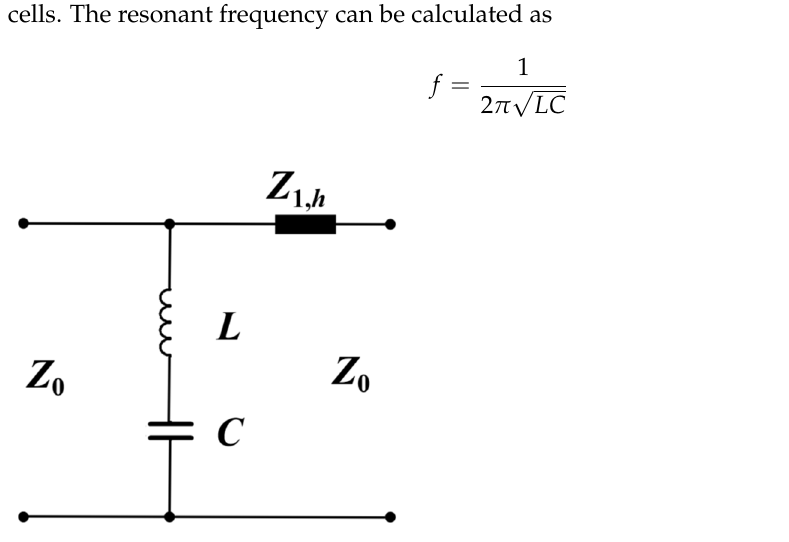
Figure 2. Equivalent circuit model of the proposed FSS.